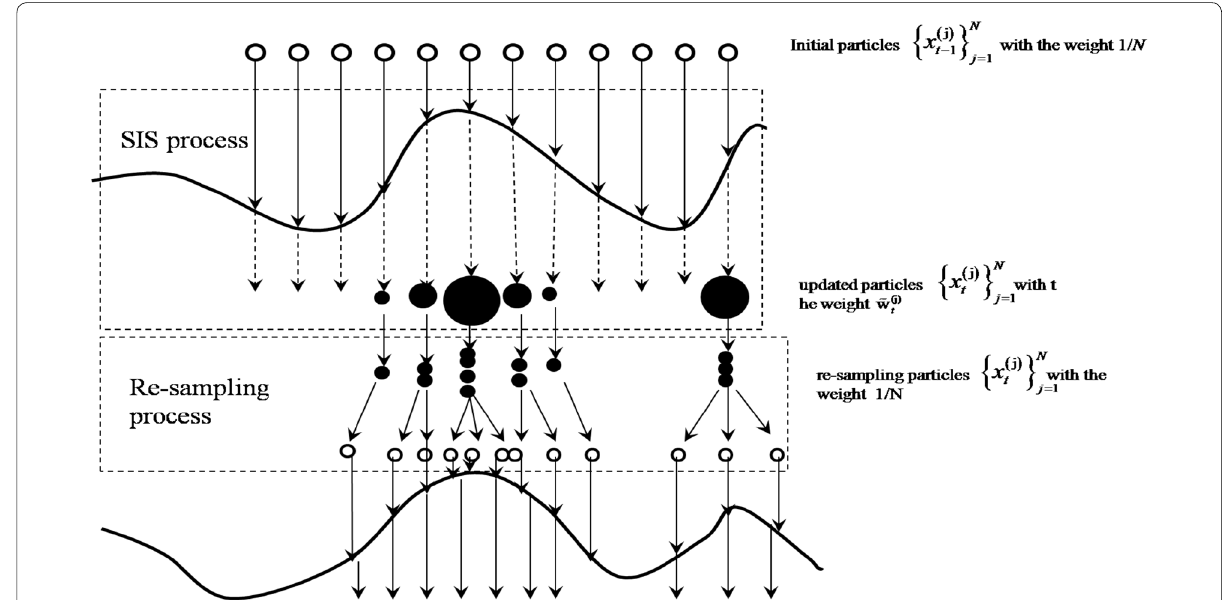
Figure 2 Diagram of resampling